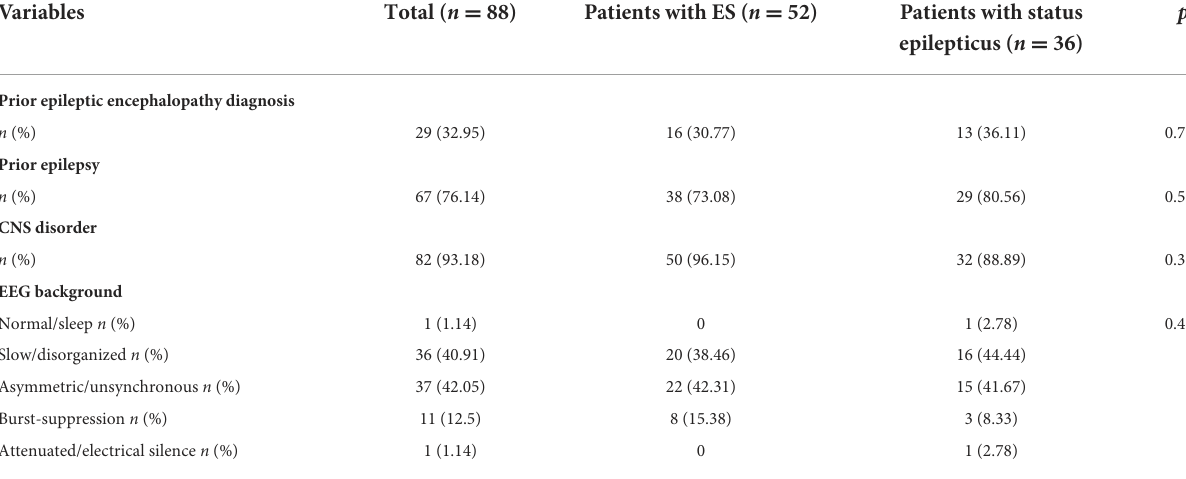
TABLE 2 Analysis of related factors for status epilepticus in patients with electrographic seizures.